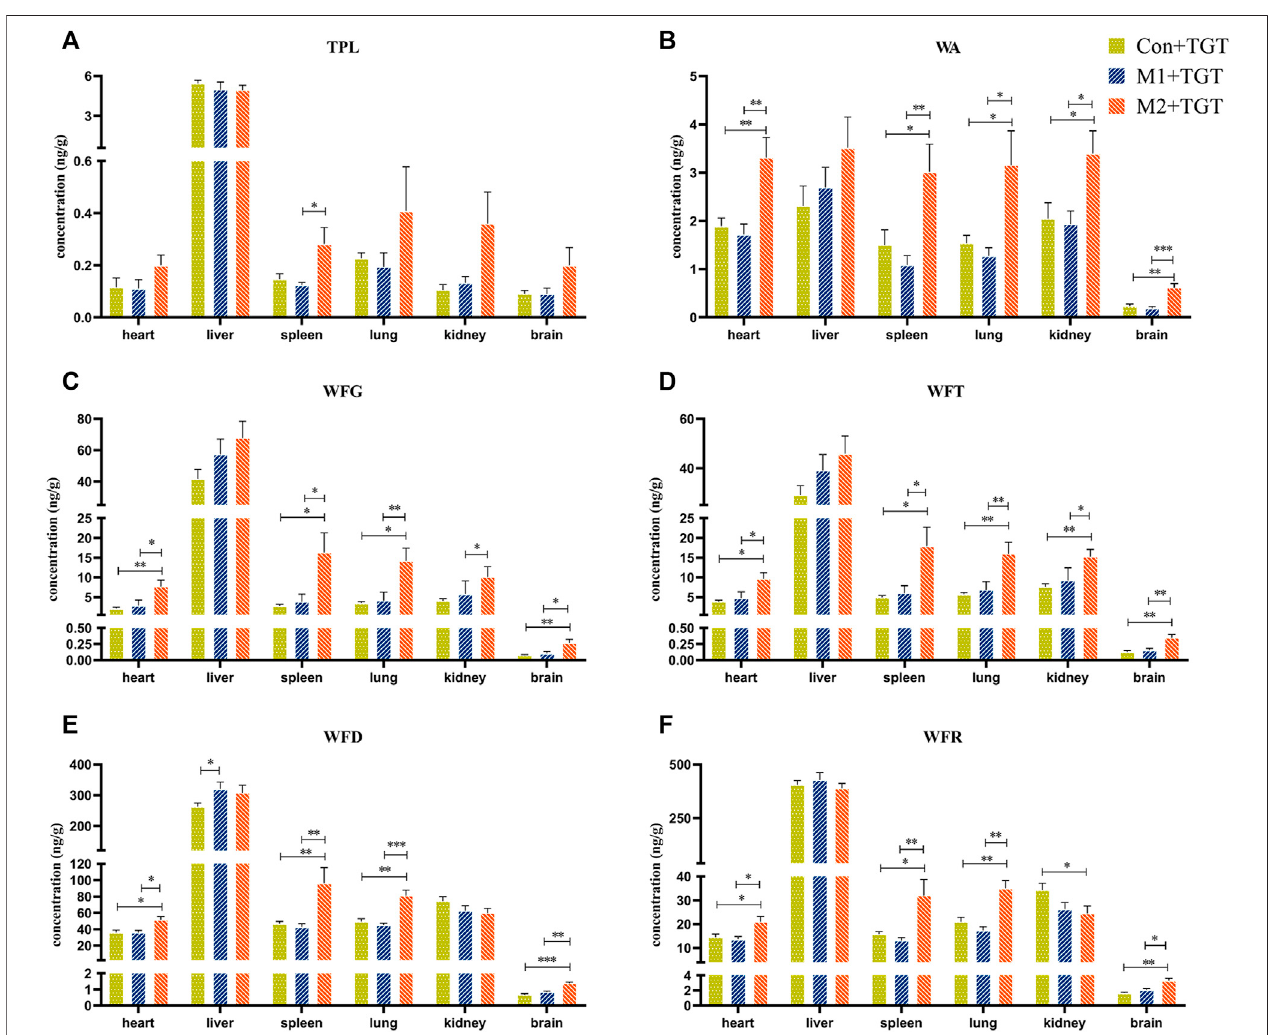
FIGURE 6 | Tissue distributions of the six key TGT components in the normal and two types of adriamycin-induced-NS rats 1 hour after a single TGT oral gavage dose of 10 mg/kg (mean ± SD, n = 7). Con + TGT, the normal rats; M1 + TGT, the early-stage NS rats; M2 + TGT, the advanced-stage NS rats. TPL (A) , WA (B) , WFG (C) , WFT (D) , WFD (E) , WFR (F) , p p < 0.05, pp p < 0.01, ppp p < 0.005 versus Con + TGT or M1+TGT.